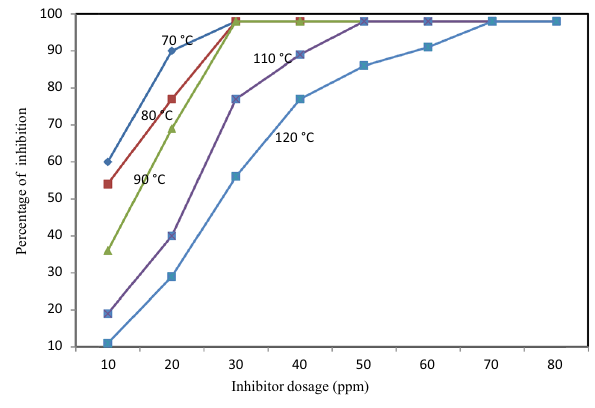
Table 3 MA-SMADS copolymer inhibition efficiency on BaSO